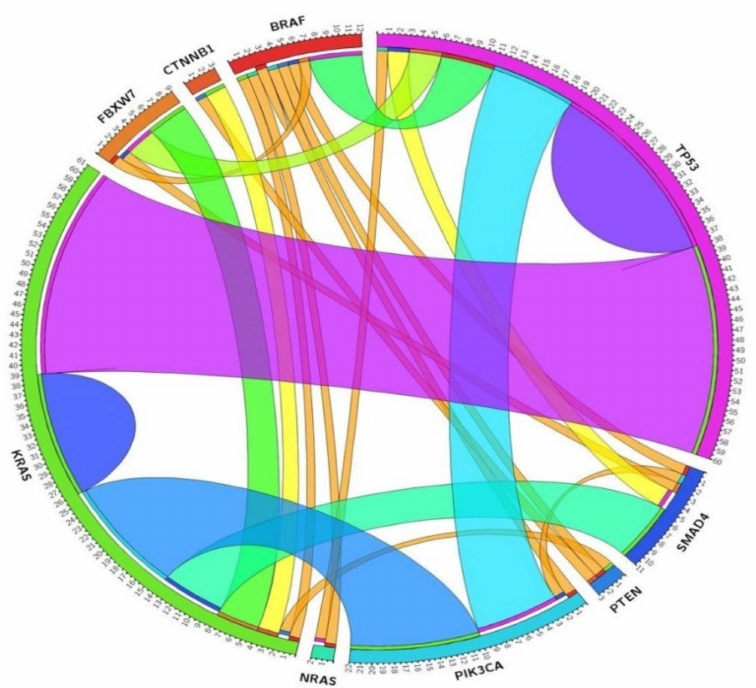
Figure 3. Circos diagram. Associations among the most prevalently mutated genes in mCRC patients.